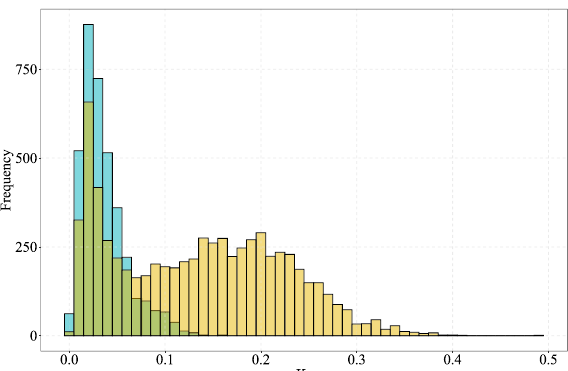
Fig. 4 Frequency of g ( x ) value in countries from HMD and WPP. Dashed lines are at values green and WPP data in yellow